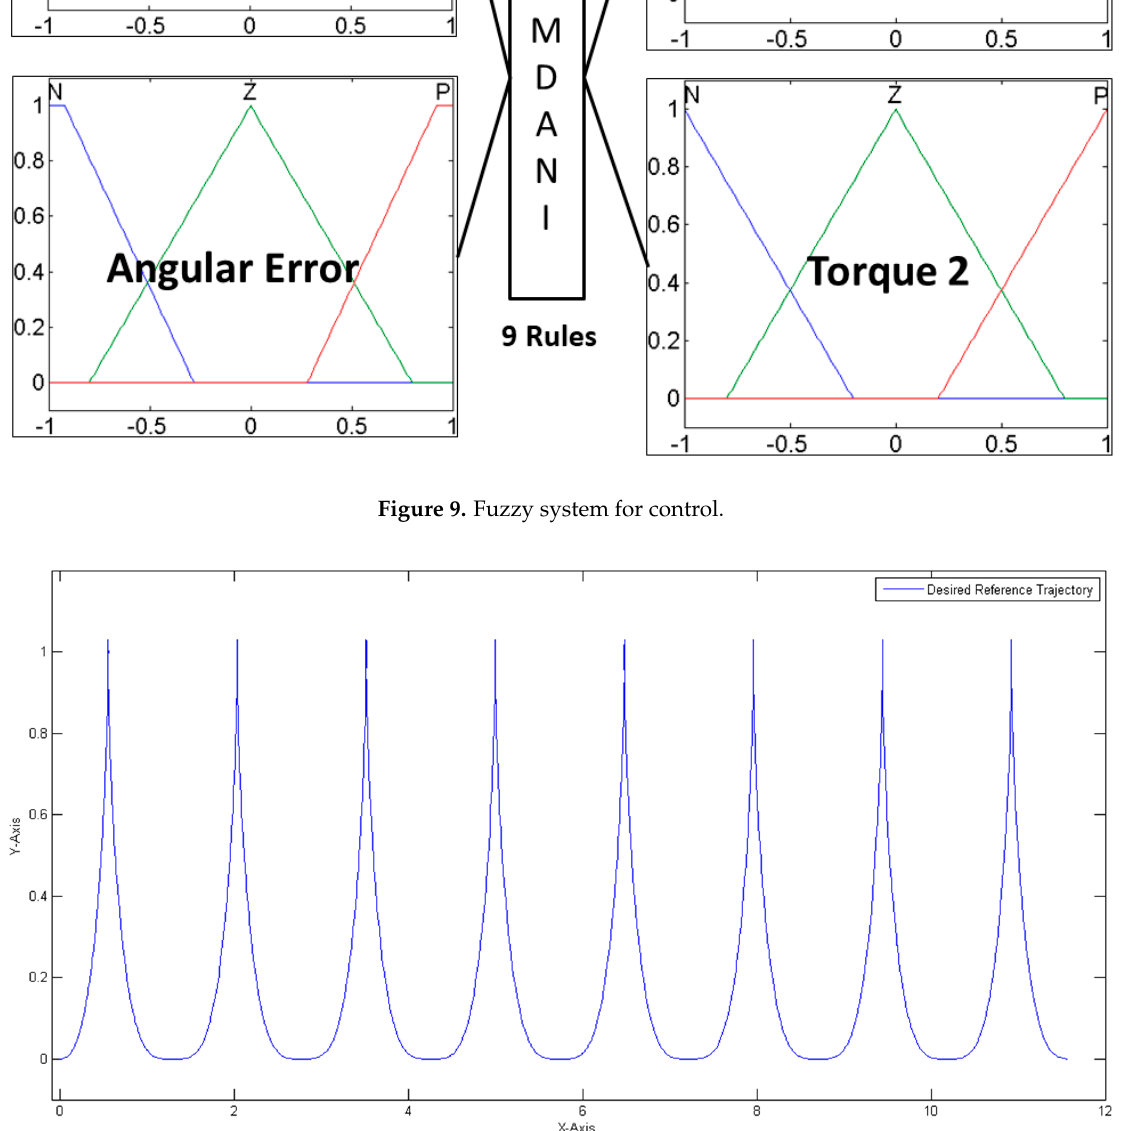
Figure 10. Reference trajectory for the autonomous mobile robot.